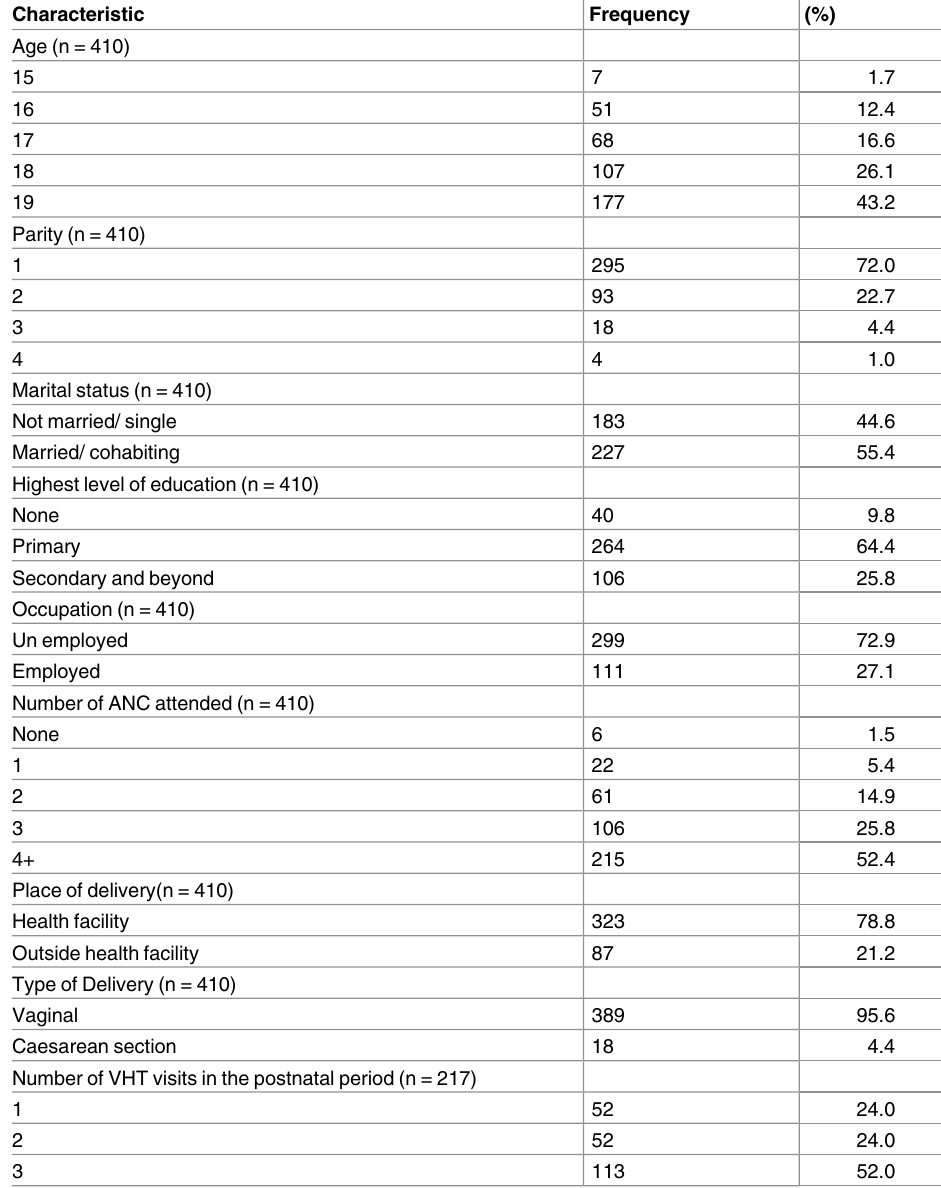
Table 1. Background characteristics of adolescent